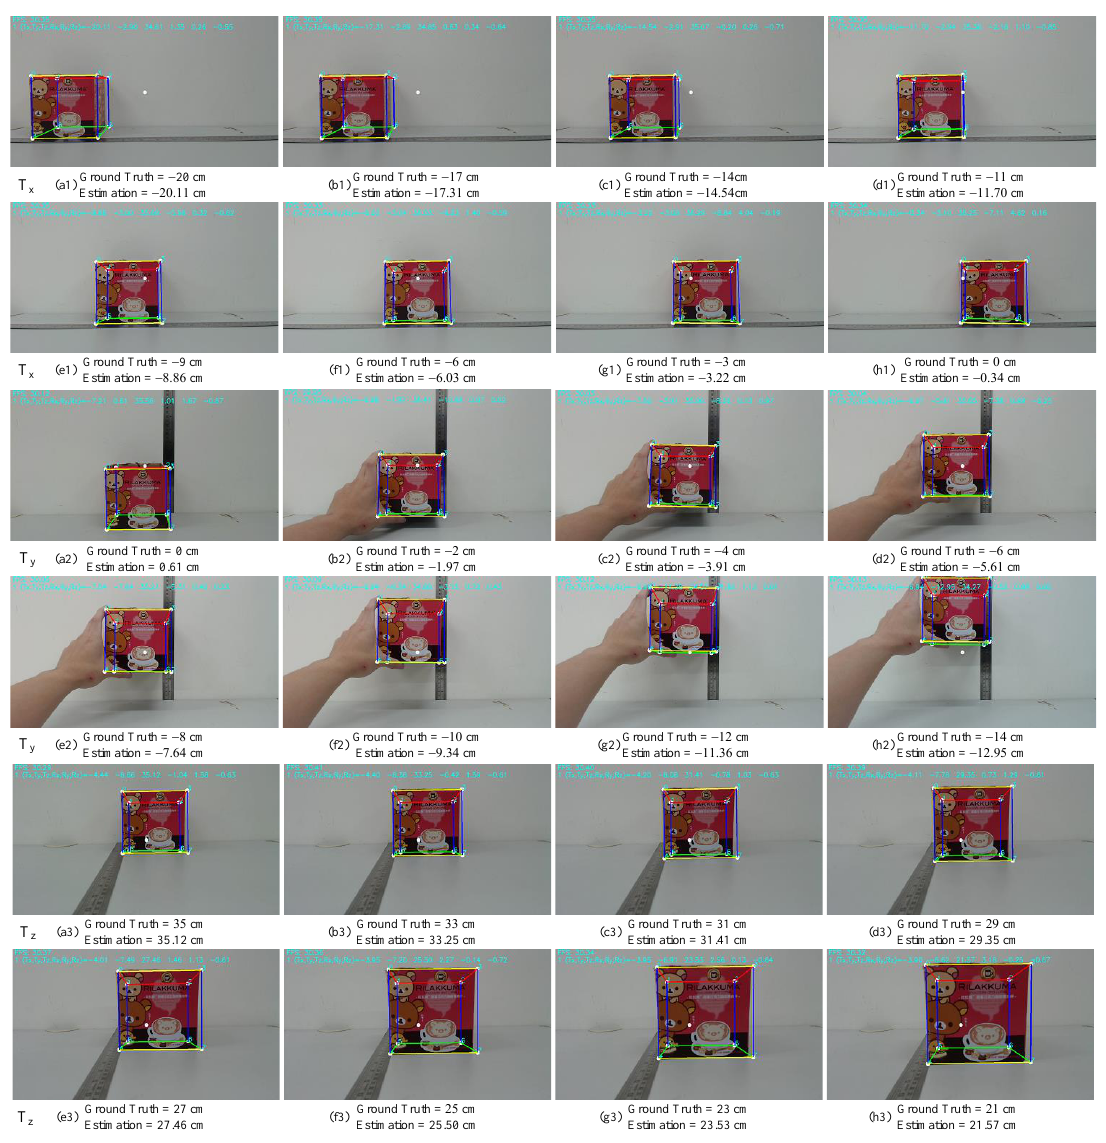
Figure 4. Experimental results of the proposed algorithm to estimate the translation motions of the OOI along the ( a1 – h1 ) x -axis, ( a2 – h2 ) y -axis and ( a3 – h3 ) z -axis.